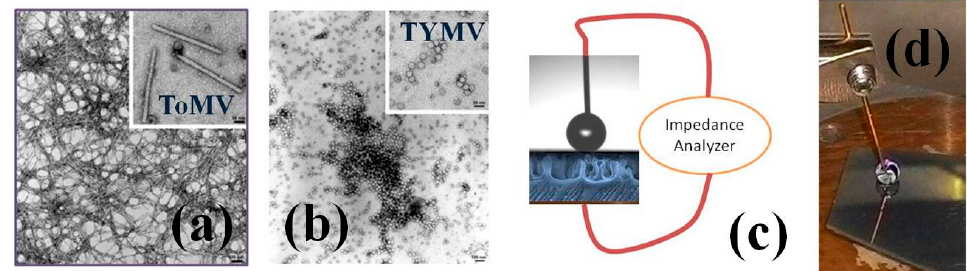
Figure 1. Transmission electron microscopy images of ToMV ( a ) and TYMV ( b ). Bar sizes are 500 nm and 10 nm in the main pictures and in the insets, respectively; ( c ) Simplified sketch of the droplet/ textured p-type silicon (T-pSi)-based device and the connection to the measurement setup; ( d ) Photograph representing the typical virus particles-in-solution droplet on top of the highly hydrophobic T-pSi surface and one of the two needle probes for the connection to the experimental setup (see text).